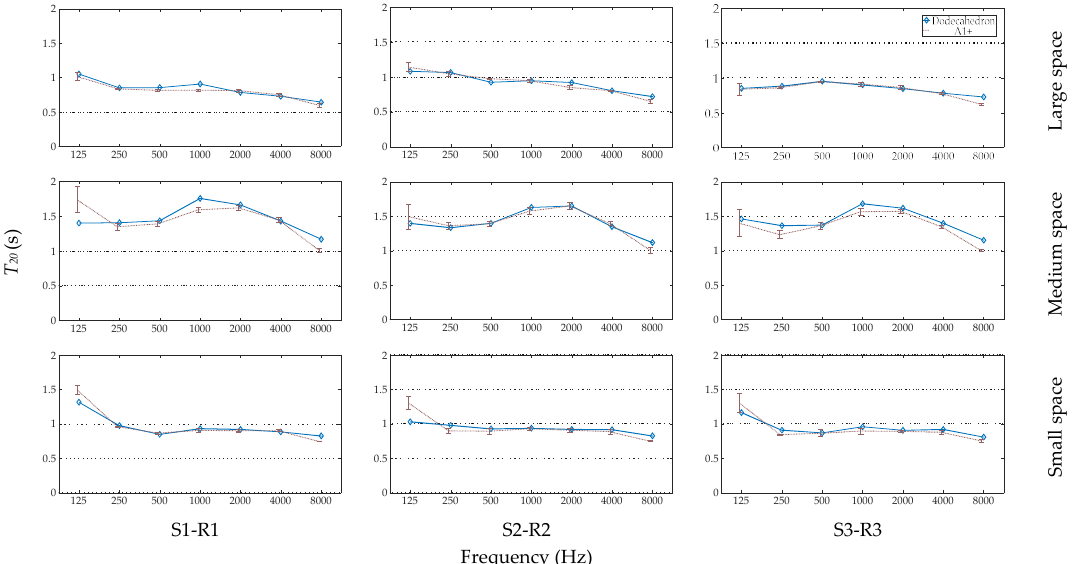
Figure 9. T 20 measurements at three positions for three different spaces (i.e., large, medium, small). Error bars represent measured standard deviation.